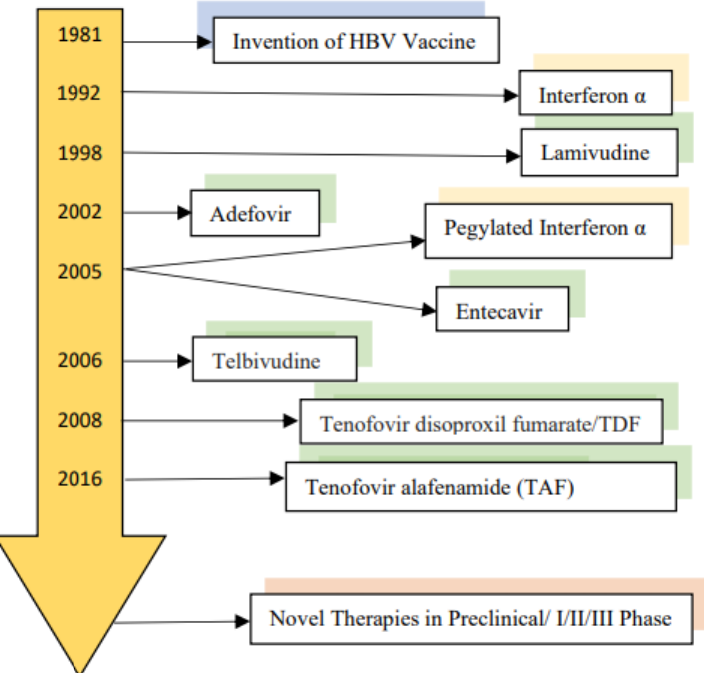
Figure 3. Development and approval of the HBV Therapy.